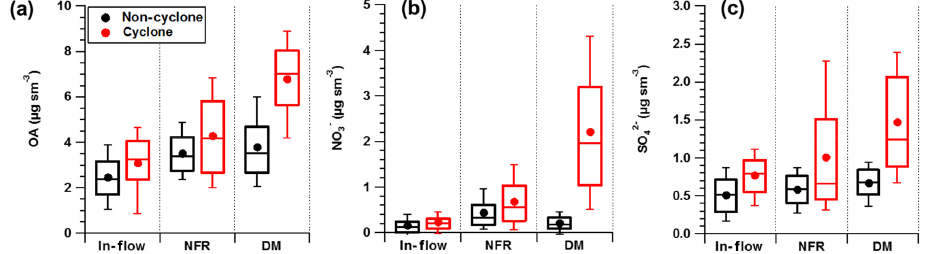
Figure 9. Statistical representation of the distribution of the mass concentrations of aerosol species (OA, NO − regions. The box and whiskers indicate 10th, 25th, 75th, and 90th percentiles, while the solid lines and circles mark the median and mean values, respectively.